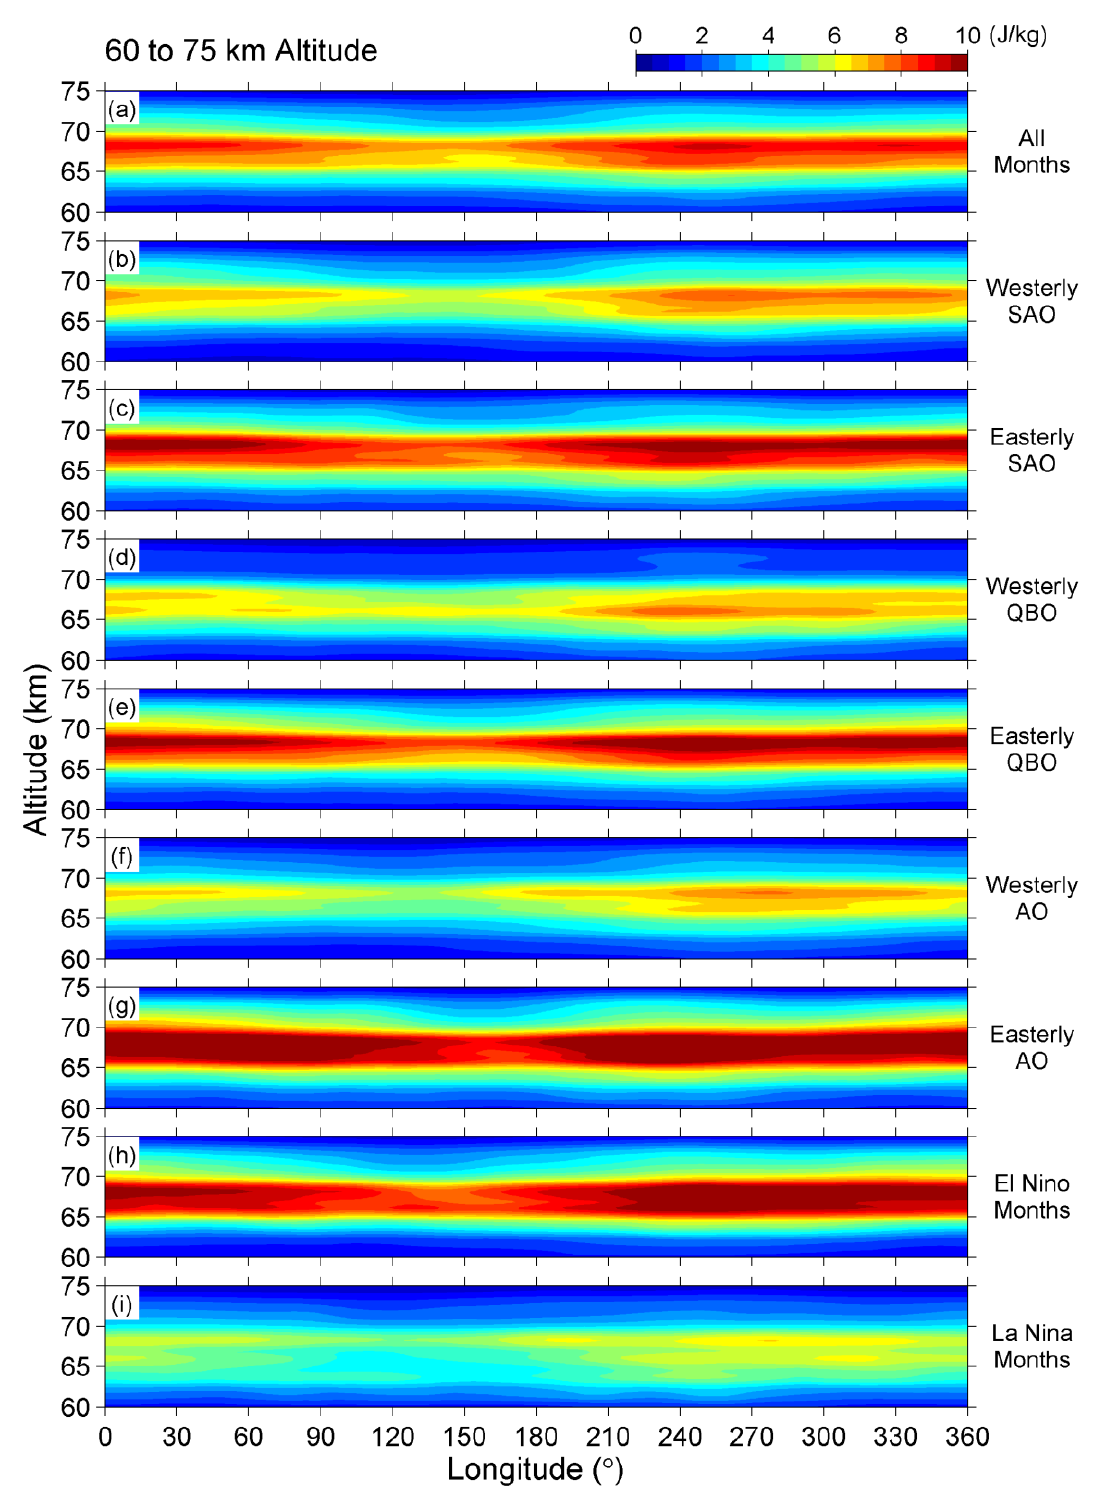
Figure 9. Same as Figure 7 but showing the values at 60–75 km altitude with a different color axis scaling.